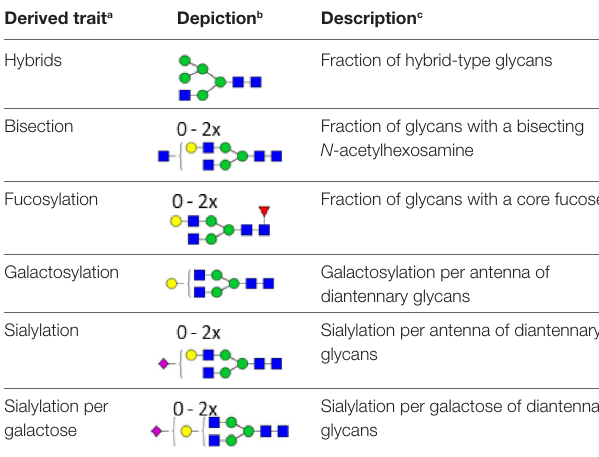
Table 2 | Subclass-specific-derived traits.